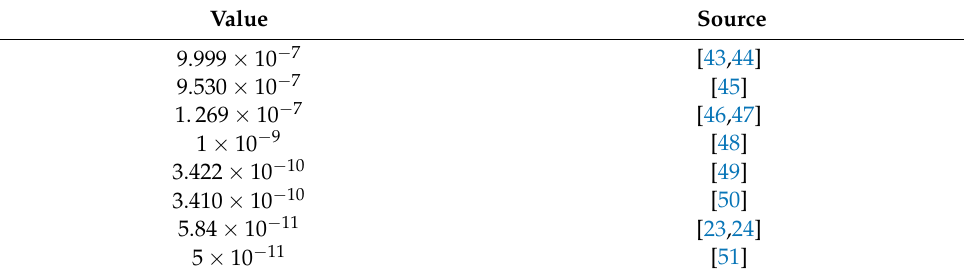
Table 3. Estimated values of effector T cells efficacy on recognising and eliminating cancer cells in other researches concerning the mathematical modelling of both solid and non-solid tumours by means of first-order